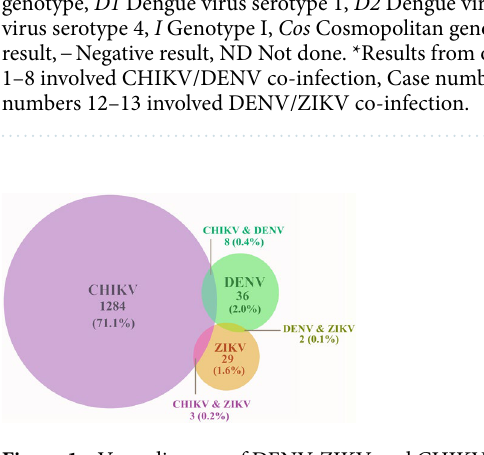
Figure 1. Venn diagram of DENV, ZIKV, and CHIKV mono-infection and co-infections found in studied samples. 1806 serum (511 CHIKV-negative and 1295 CHIKV-positive patients) from our previous chikungunya cohort study 13 were retrospectively detected for ZIKV and DENV by using RT-PCR. A total of 29 ZIKV mono- infection cases and 36 DENV mono-infection cases were identified. 13 co-infection cases were observed, of which 8 cases were DENV/CHIKV co-infection, 3 cases were ZIKV/CHIKV co-infection with ZIKV, and 2 cases were DENV/ZIKV